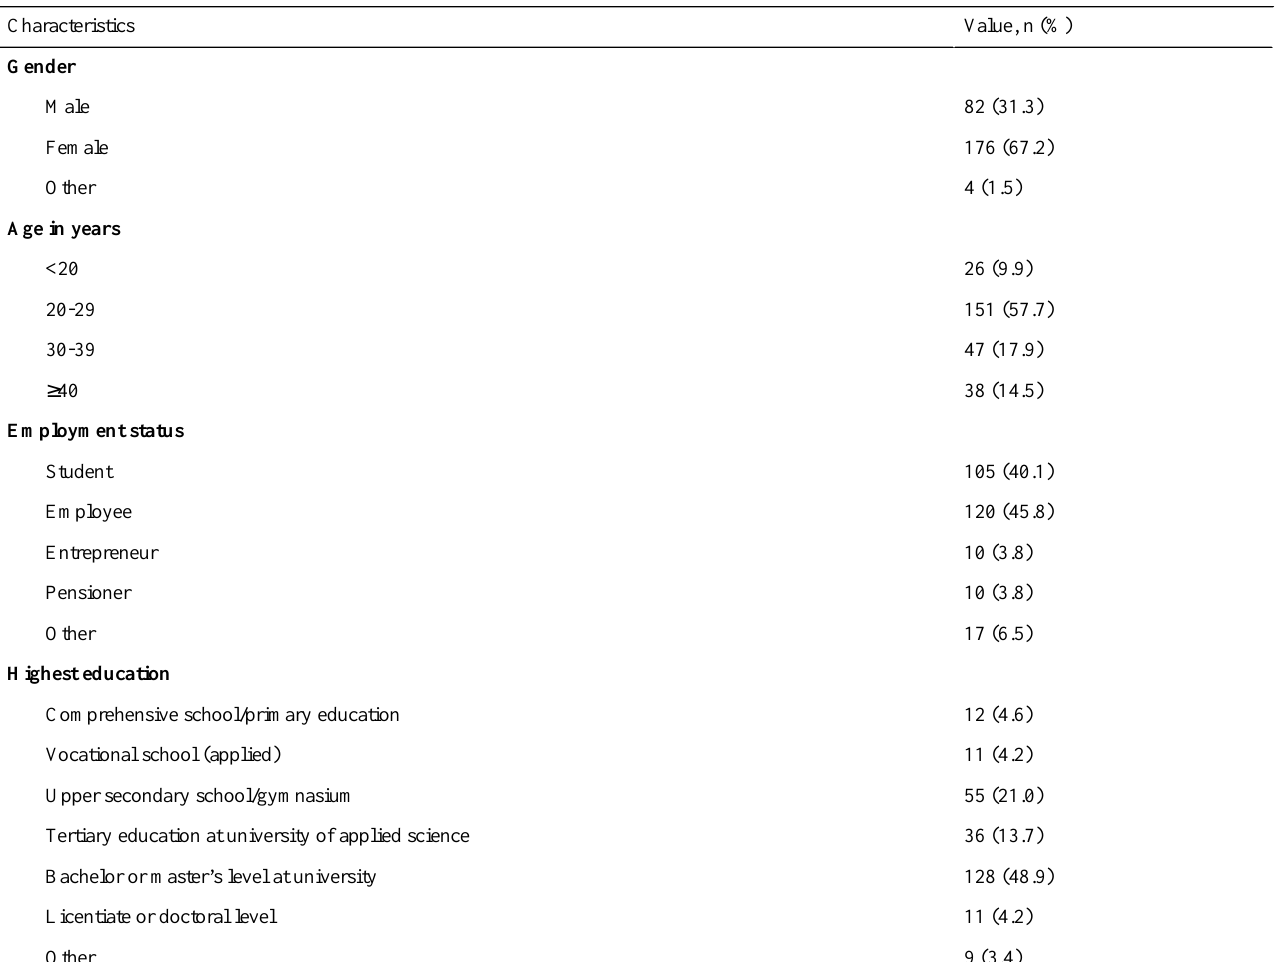
Table 1. Sociodemographic characteristics of the sample